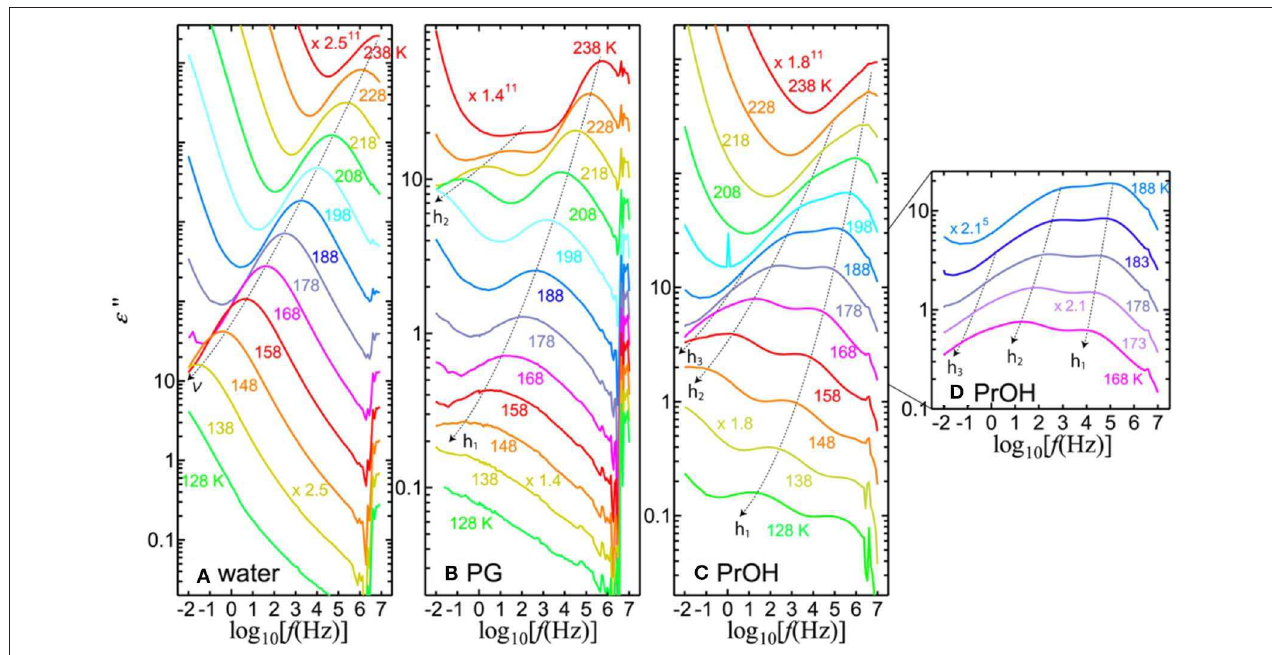
FIGURE 2 | Imaginary part of permittivity for 65 wt% (A) PVP–water, (B) PVP–PG, and (C,D) PVP–PrOH mixtures as a function of frequency and for different temperatures in steps of 10K except for panel (D) , which is in step of 5K. To clearly illustrate the solvent separation processes, the data are shifted vertically.